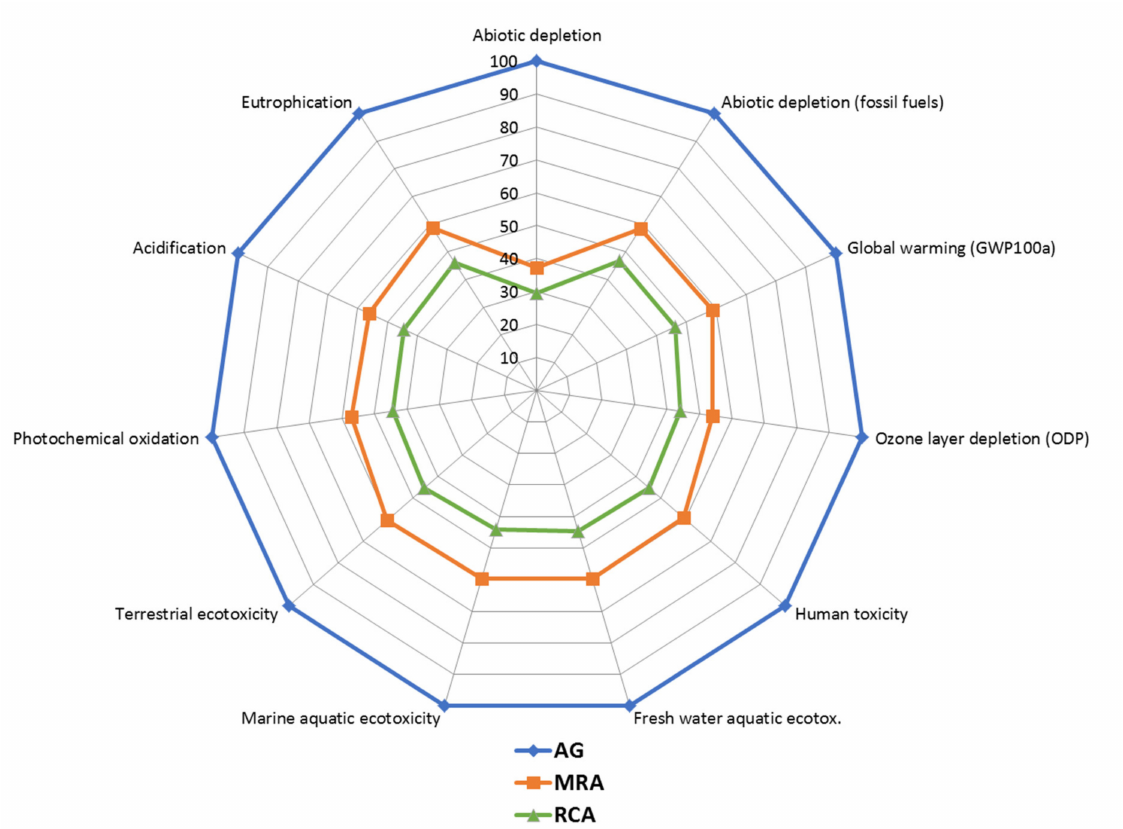
Figure 14. Comparative graph of aggregates production impact assessment.